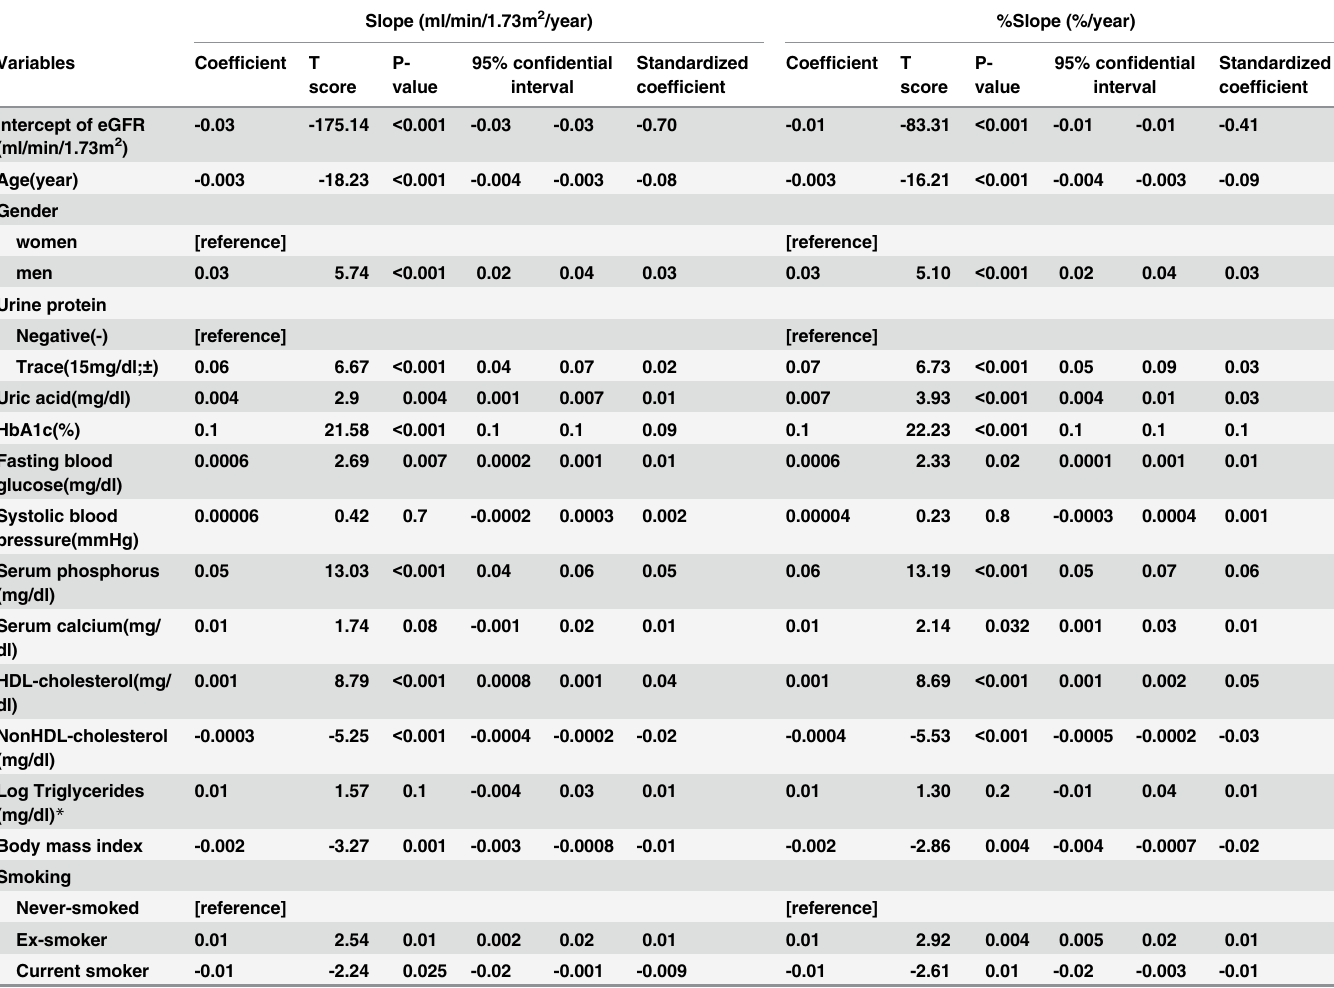
Table 5. Rate of eGFR decline (Slope and %Slope) evaluated by linear least-squares regression analysis using 15 factors at baseline. Slope (ml/min/1.73m 2